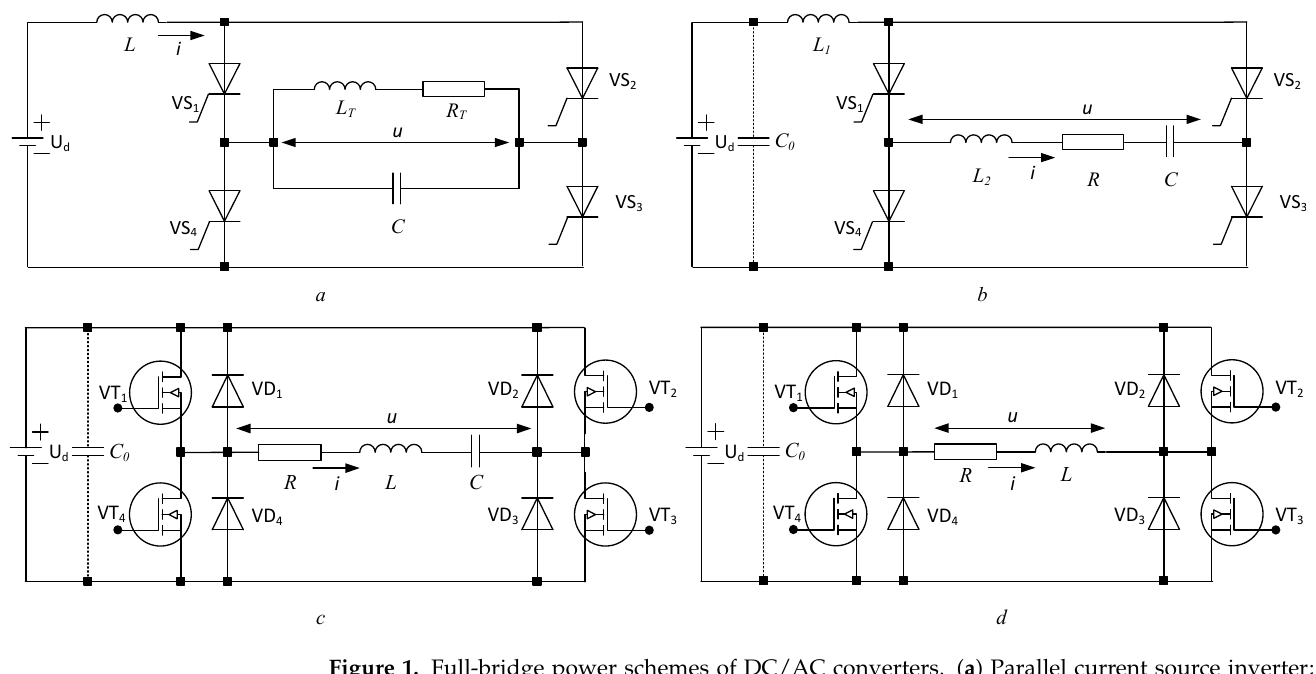
Figure 1. Full-bridge power schemes of DC/AC converters. ( a ) Parallel current source inverter; ( b ) series resonant DC/AC converter; ( c ) resonant DC/AC converter with reverse diodes; ( d ) voltage source inverter.